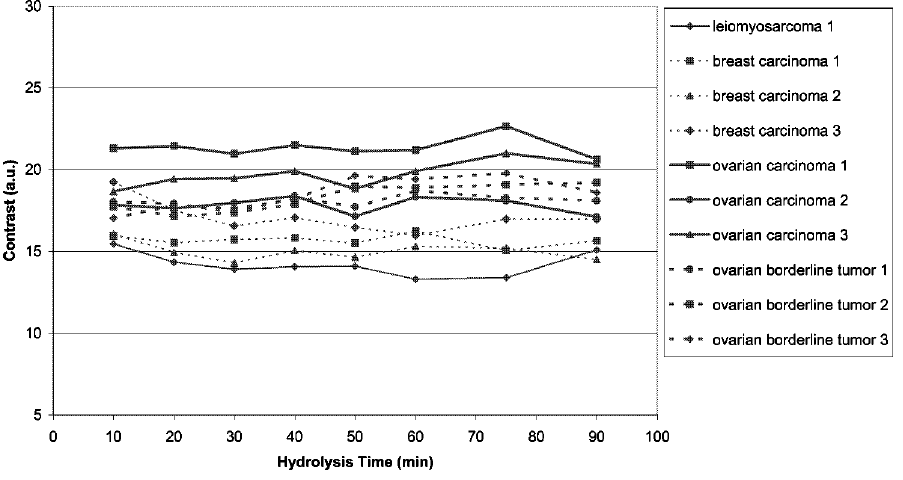
Fig. 3. Hydrolysis profiles based on “contrast” in breast carcinoma, ovarian serous adenocarcinoma, ovarian serous tumor of borderline malig- nancy and